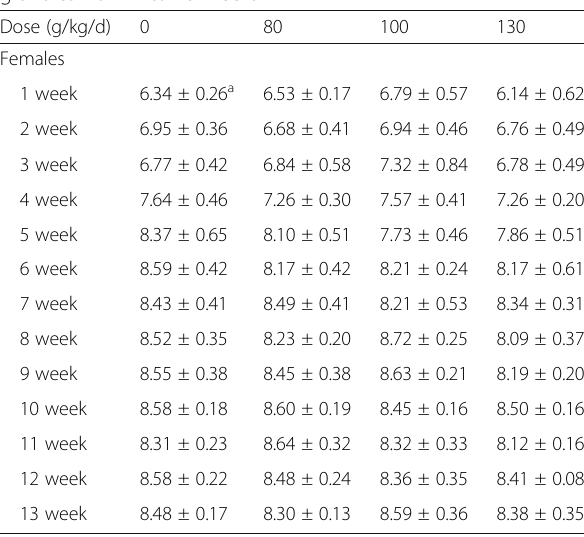
Table 3 Food consumption of Female rats treated with